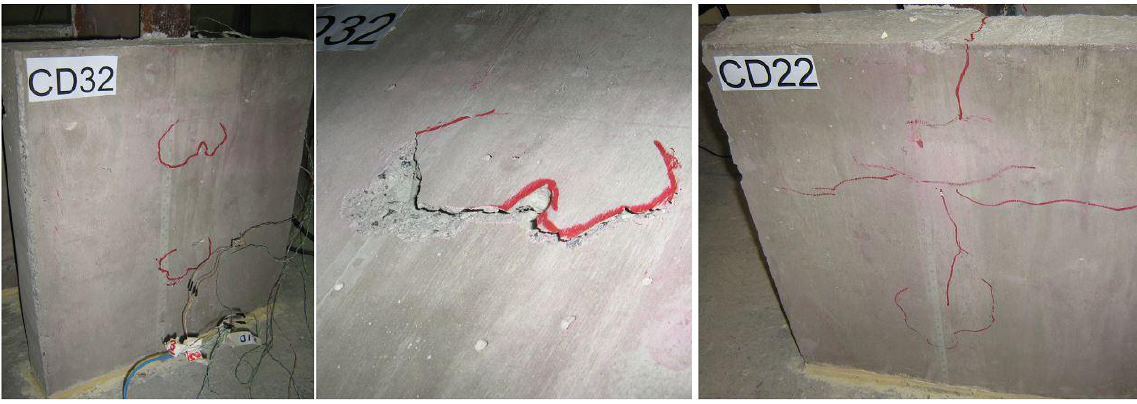
Figure 17. Cracks on push-out models’